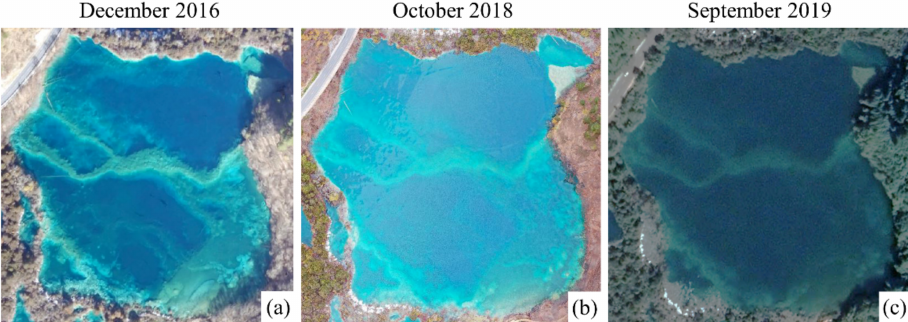
Figure 9. Orthomosaics of Lying Dragon Lake from a fixed-wing ( a ) and a rotary-wing UAV ( b ), and Google Earth ( c ). The shooting date of the images is marked at the